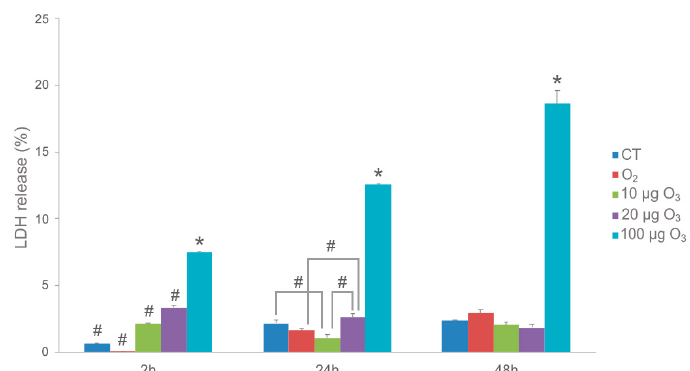
Figure 1. LDH assay on AT samples. Histograms show the mean value ± SE of percentage of tissue viability after 2 h, 24 h and 48 h from the treatment. Statistical difference is indicated by # ( p < 0.05). The value referring to 100 µg O 3 is statistically different from all other samples at each time point (* p < 0.001). CT, control.